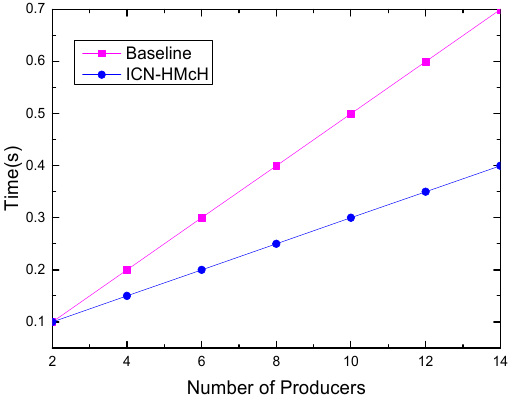
Figure 18. Multi-source data retrieval results.